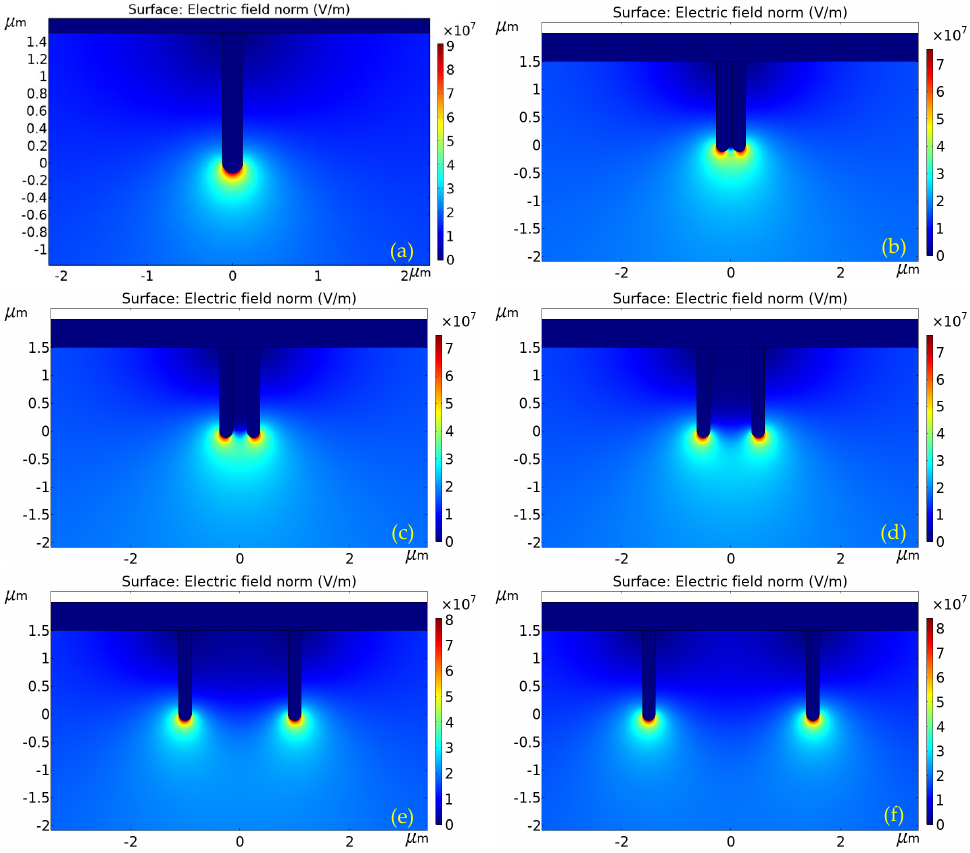
Figure 9. Distribution of electric field around the anode nanowires in the discharges. ( a ) One nanowire; ( b ) two nanowires, 0.06 μm spaced; ( c ) two nanowires, 0.26 μm spaced; ( d ) two nanowires, 0.76 μm spaced; ( e ) two nanowires, 1.76 μm spaced; and ( f ) two nanowires, 2.76 μm spaced.